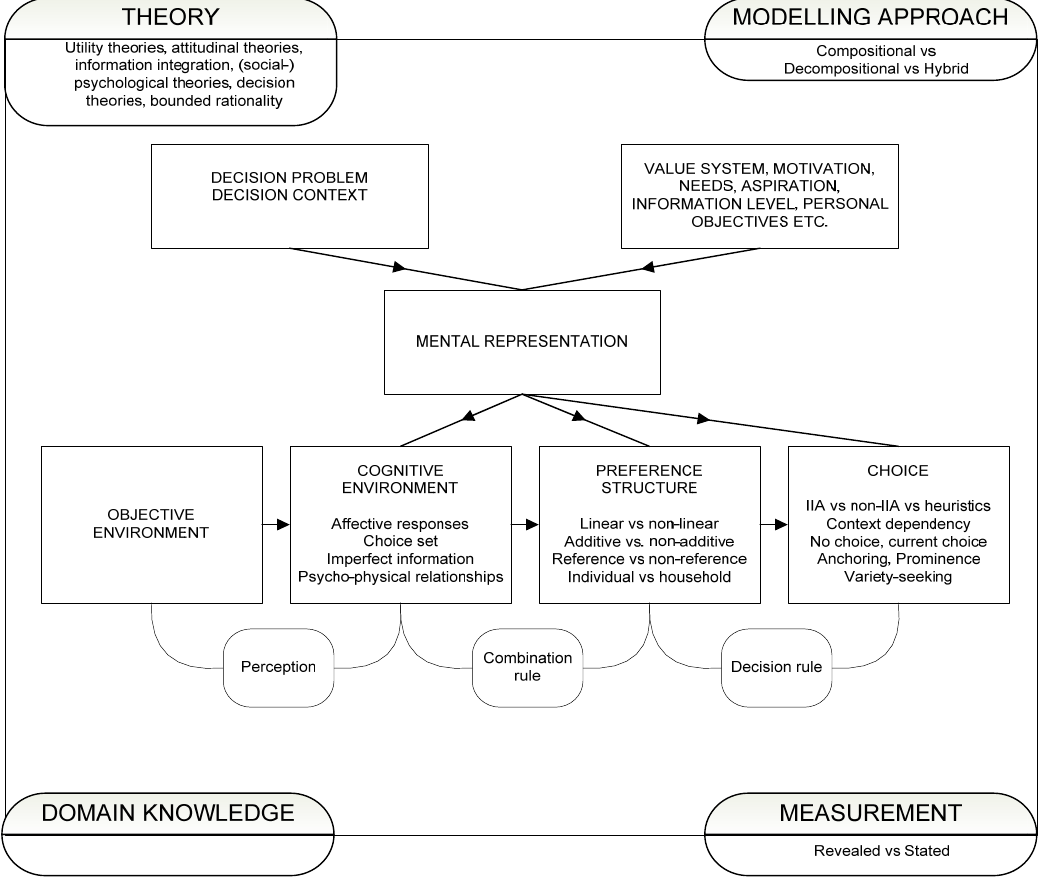
Figure 1. Conceptual framework and key topics in seminal behavioural analyses in marketing, urban planning and transportation